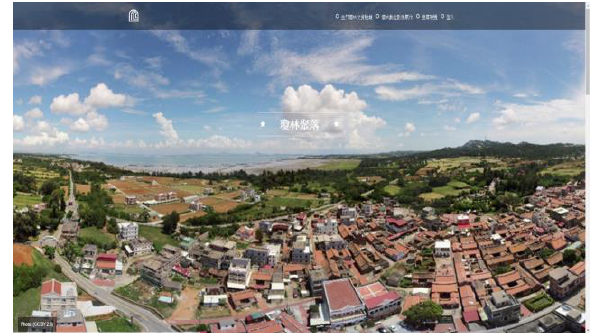
Figure 6.System platform on home page